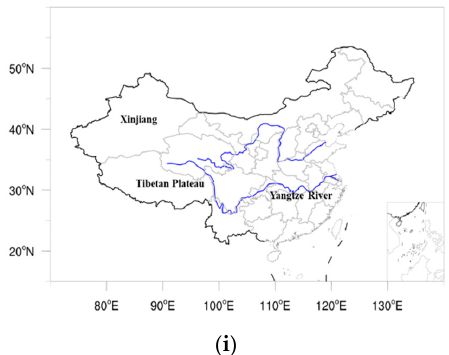
Figure 1. Distribution of mean air temperature in four seasons. ( a – d ) represent the spatial distribution of the mean air temperature of HRCLDAS in winter, spring, summer and autumn, respectively; ( e – h ) represent the spatial distribution of the mean air temperature of ERA5 in winter, spring, summer and autumn, respectively; ( i ) geographical map.